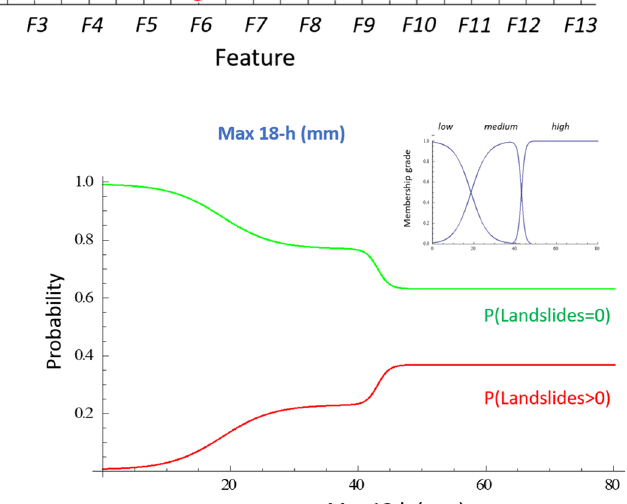
Fig. 4 Probability of landslide and non-landslide associ- ated with the model based on cumulative